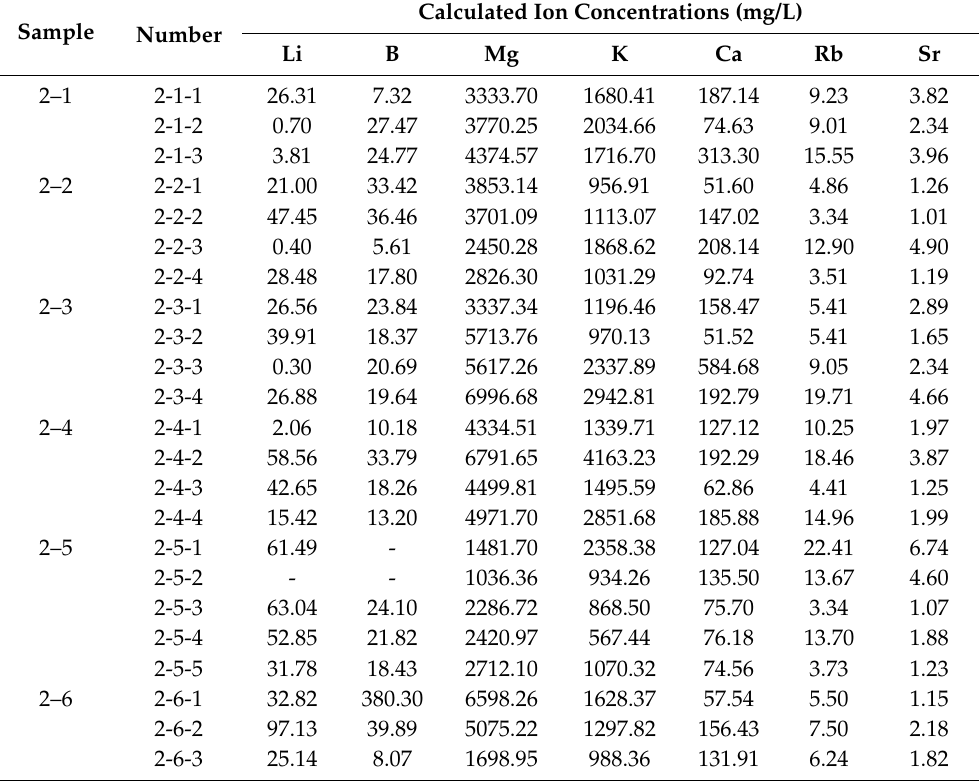
Table 4. Ion contents of halite fluid inclusions from sample